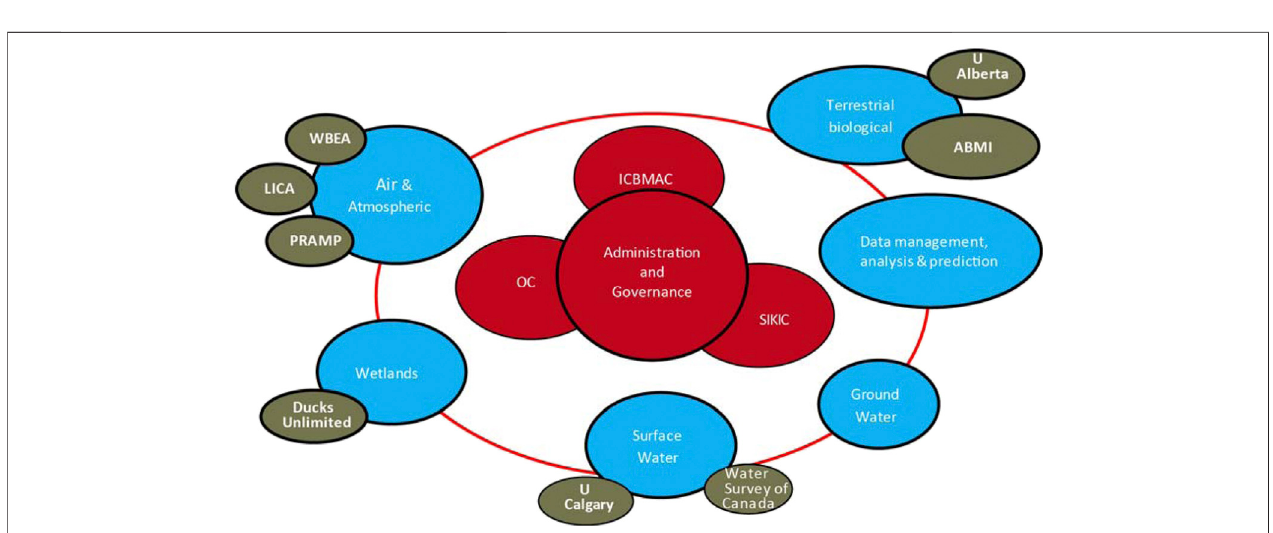
FIGURE 3 | Current administrative structure of the Oil Sands Monitoring program including central (red) administrative and governance committees (Indigenous Community Based Monitoring Advisory Committee; Oversight Committee; Science and Indigenous Knowledge Integration Committee), peripheral Technical Advisory Committees (in blue; e.g., Groundwater), and delivery partners (green) identi fi ed from the most recent publicly available workplans available (2017 – 2018) from http:// environmentalmonitoring.alberta.ca/activities/oil-sands-monitoring-projects/20172018-projects/;notshownareadditionallinkageswithEnvironmentandClimate Change Canada, Alberta Environment and Parks, or industry organizations; PRAMP (cid:1) Peace River Area Monitoring Program; See Figure 2 for additional acronym de fi nitions.